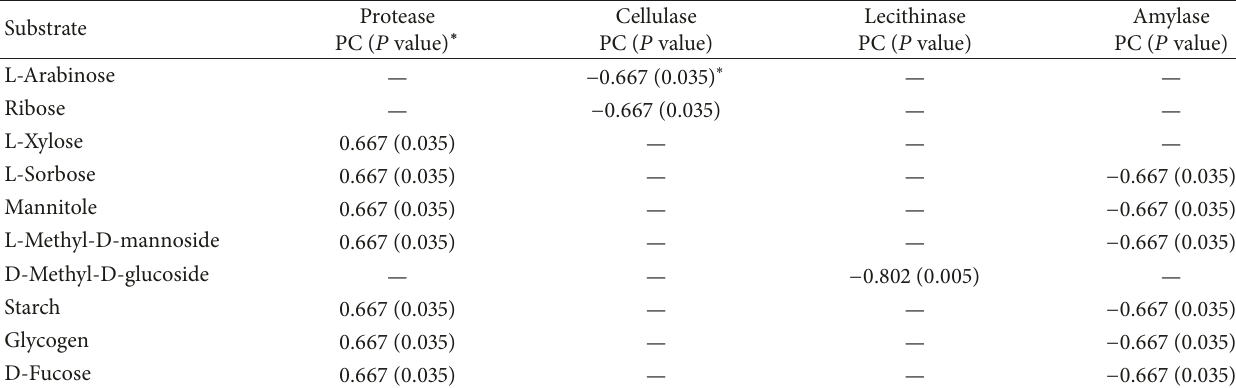
Table 5: Correlation between protease, cellulose, lecithinase, and amylase activity produced by T. hydrothermalis and B. licheniformis strains and some biochemical tests.